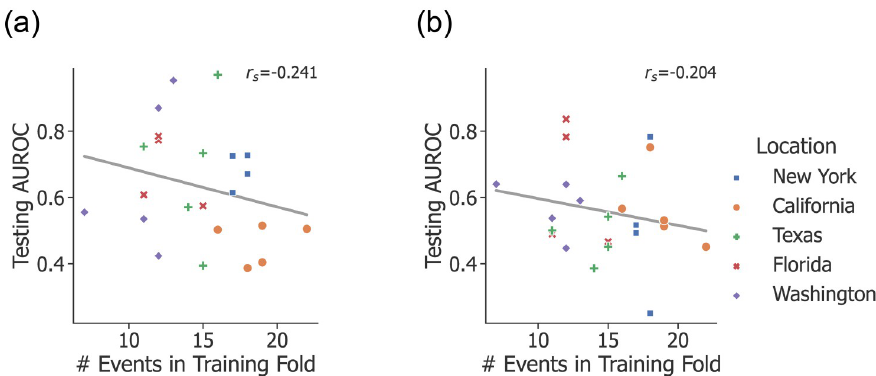
Fig 5. AUROC of each test fold as a function of the number of attacks in the corresponding training fold. These results for RF (left) and FFNN (right) show that having more attacks in the training set does not necessarily increase performance on the test set. The grey lines are regression lines, and r s is Spearman’s rank correlation coefficient.